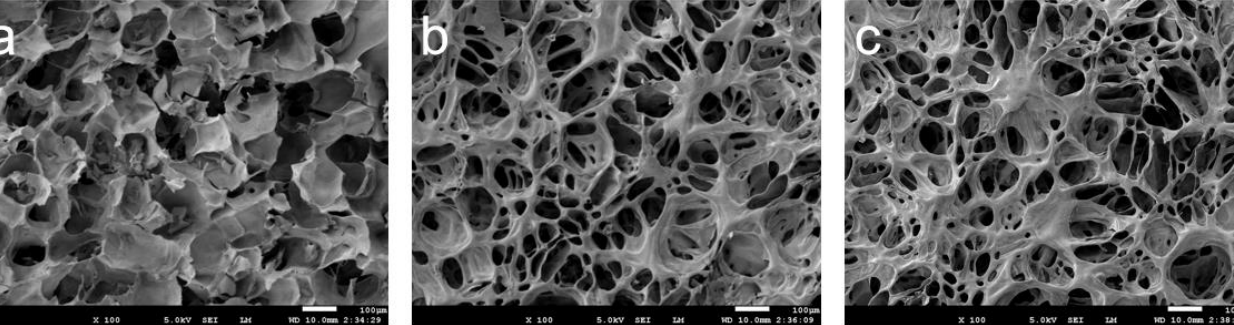
Figure 4. The formation process of supramolecular hydrogel based on the coordination of tpy and Ni 2+ .